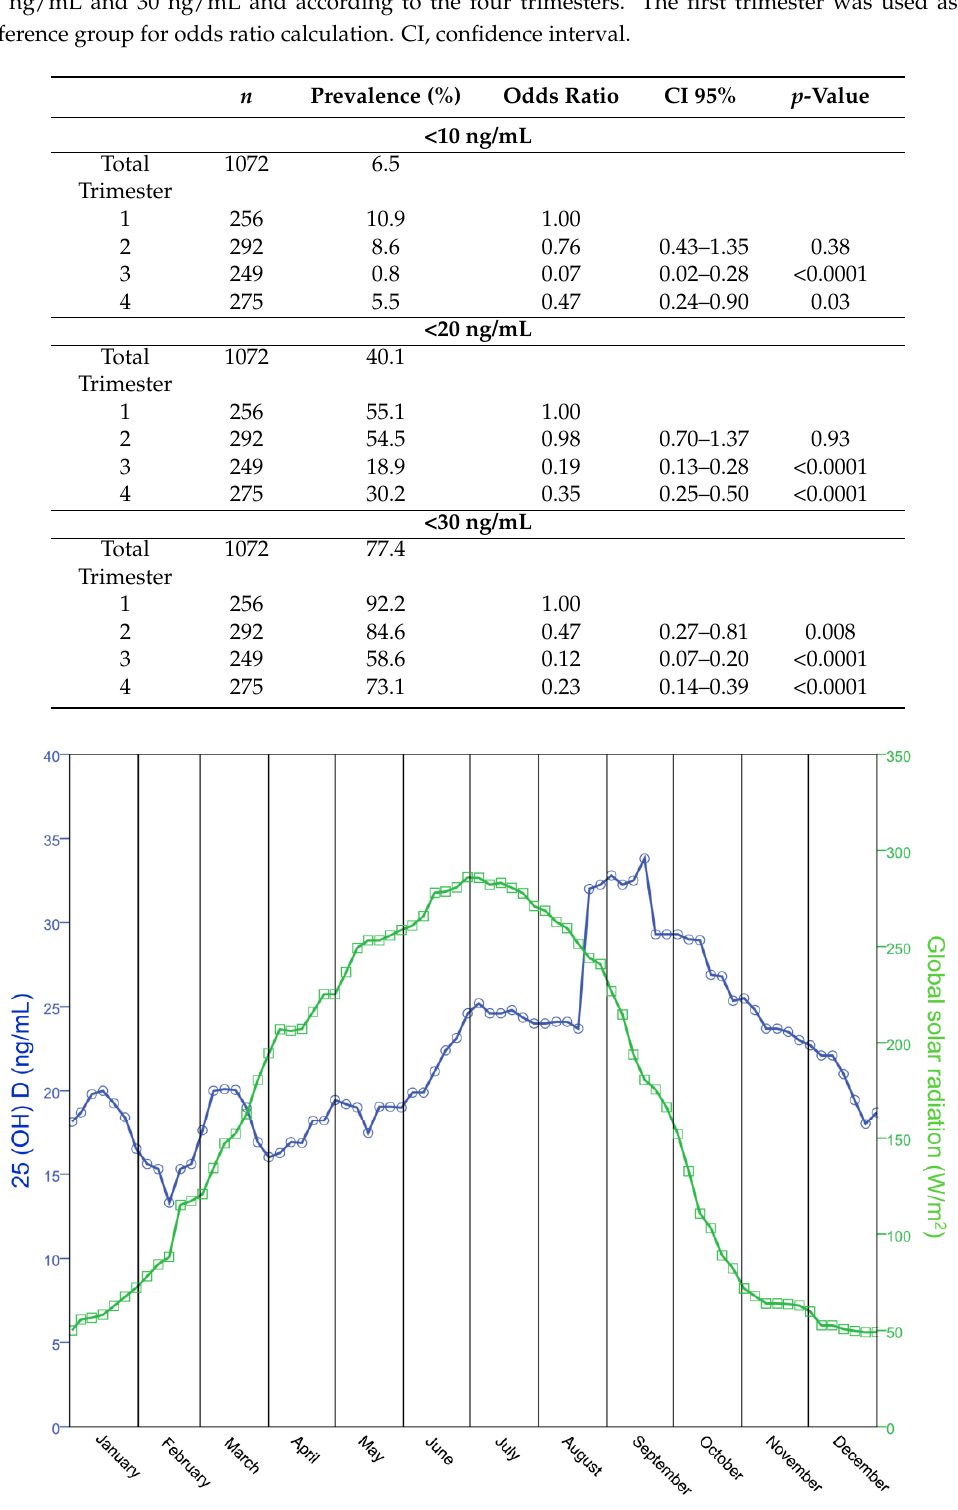
Figure 2. Relationship between solar radiation and 25(OH)D levels. Annual levels for global solar radiation is represented with green open squares and is compared to the moving median of 25(OH)D concentration (blue open circles).